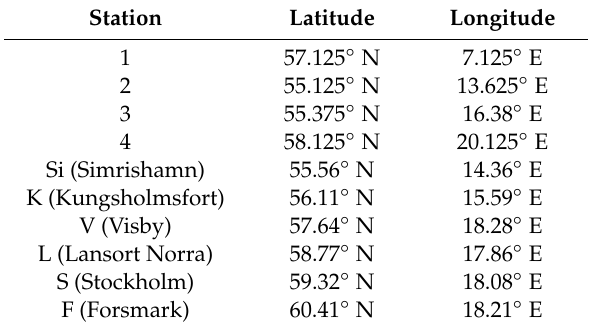
Table 2. Geographical positions of stations indicated in Figure 1.